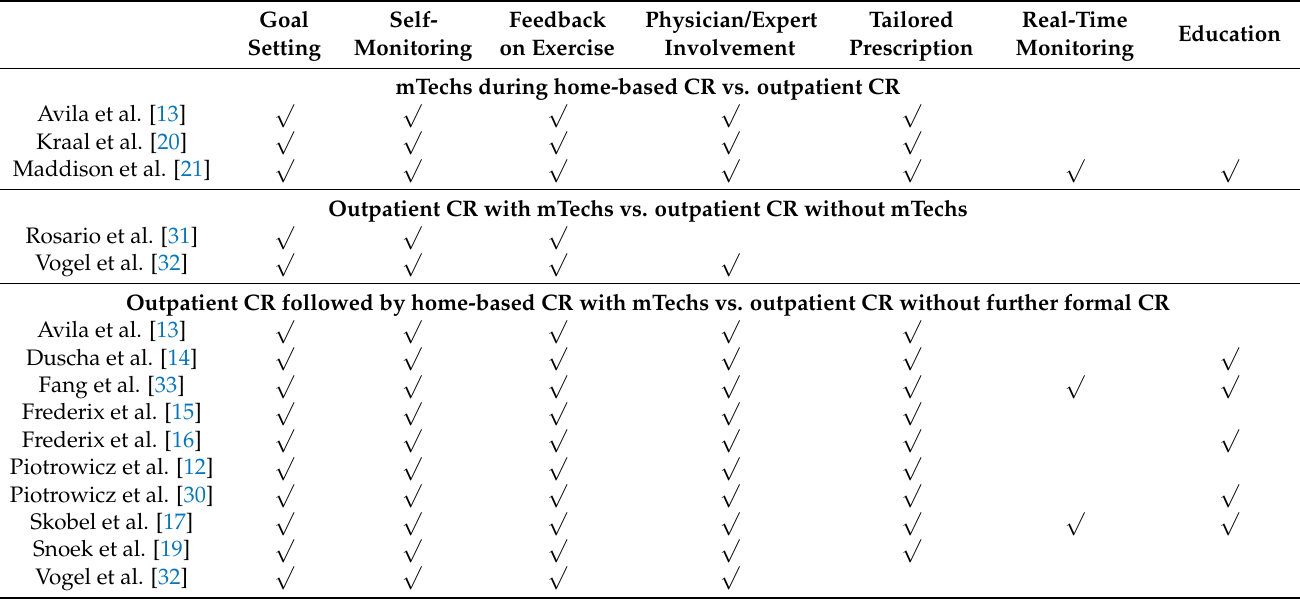
Table 4. Classification of applied behavior change techniques